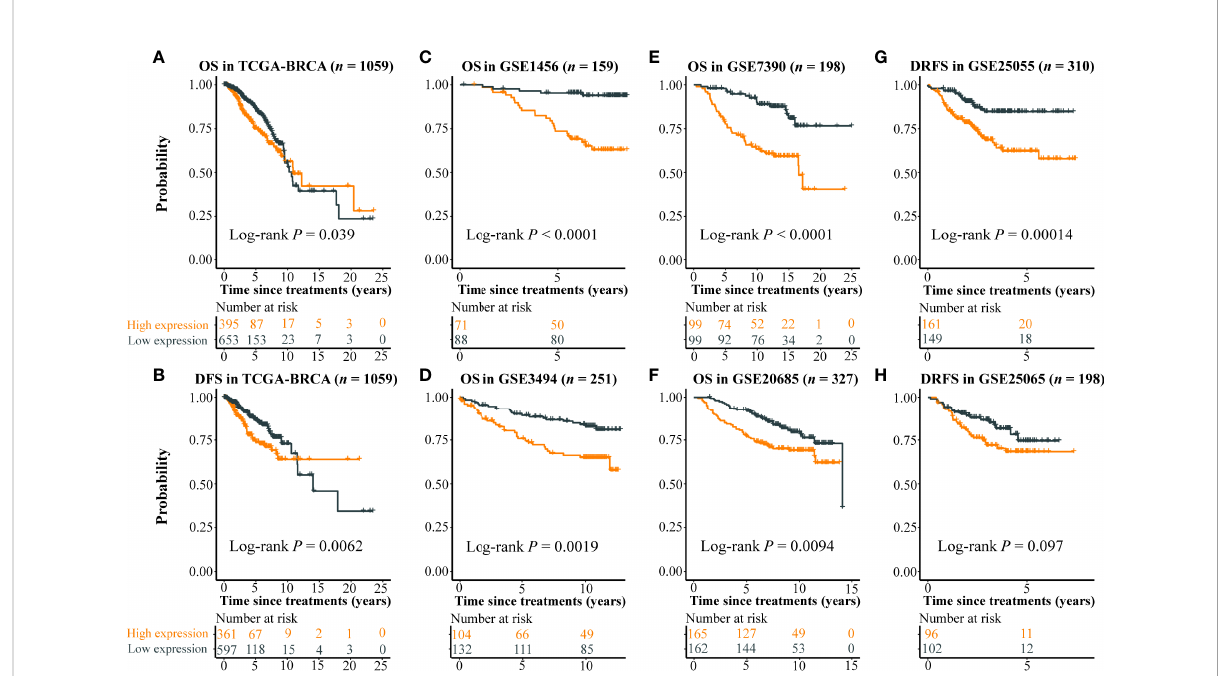
FIGURE 3 Prognostic ability of BC-8mriG. Patient strati fi cation based on expression of BC-8mriG showed signi fi cantly different OS and DFS in TCGA- BRCA dataset (A, B) . The prognostic ability of BC-8mriG was validated in six external datasets by using Kaplan – Meier analysis (C – H) . OS, overall survival; DFS, disease-free